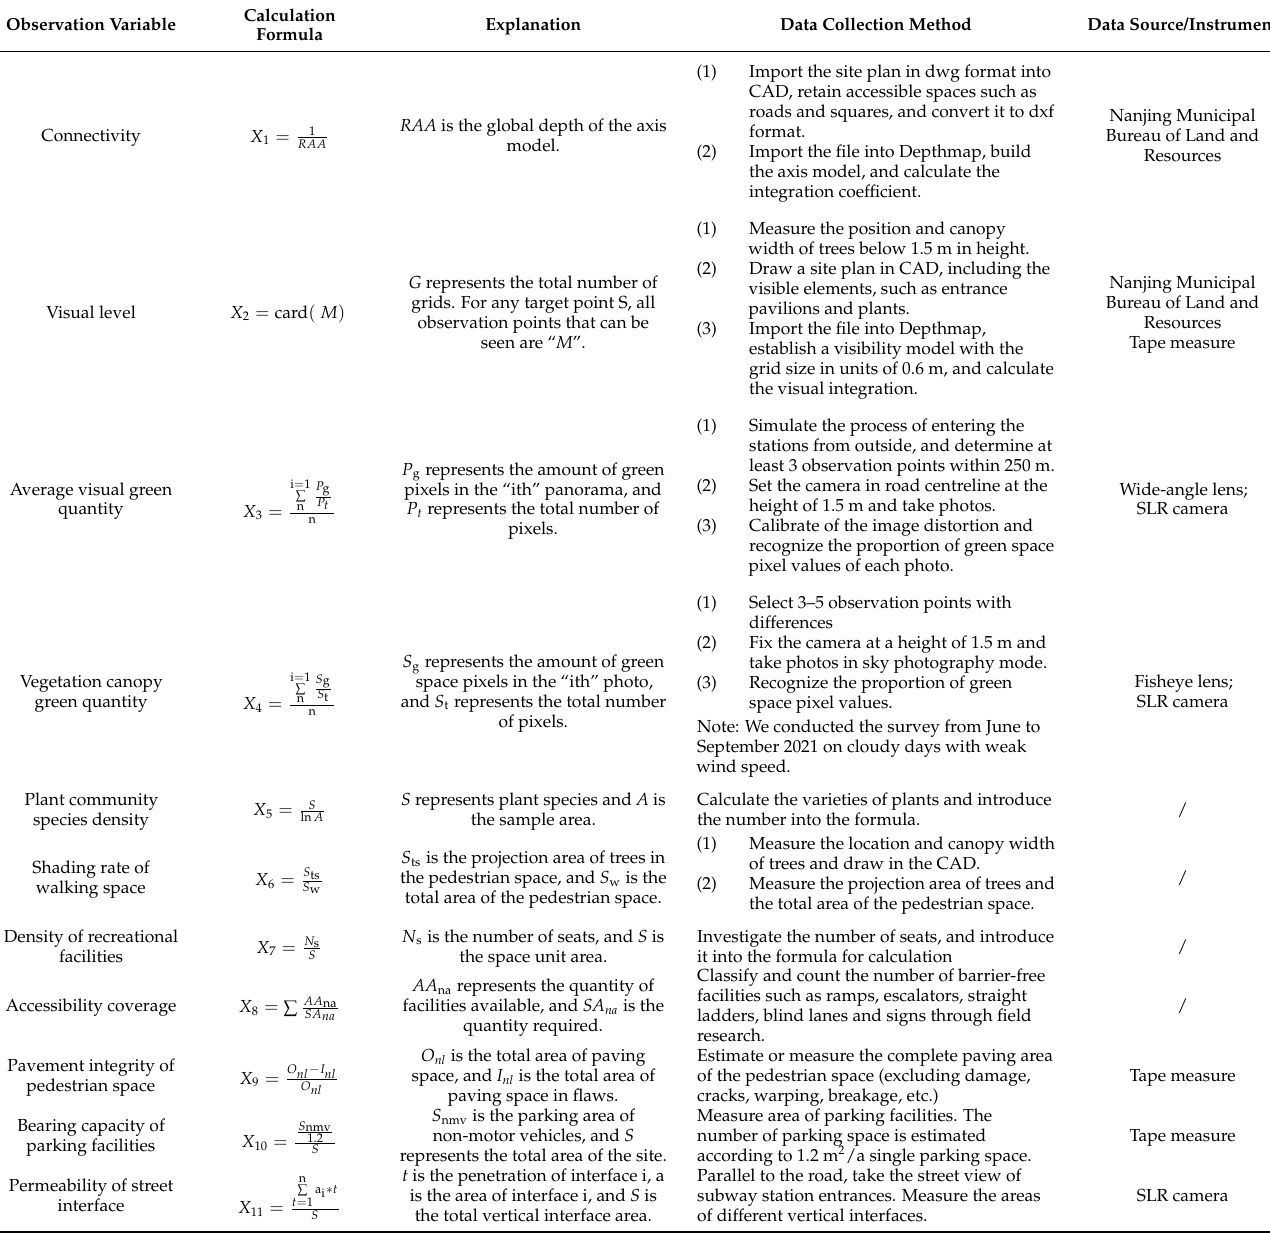
Table 2. Collection methods of observed variable